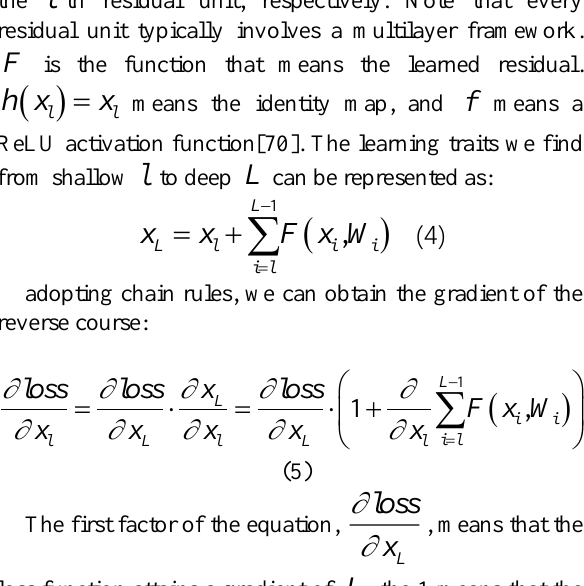
Figure 9. Squeeze-and-Excitation Networks